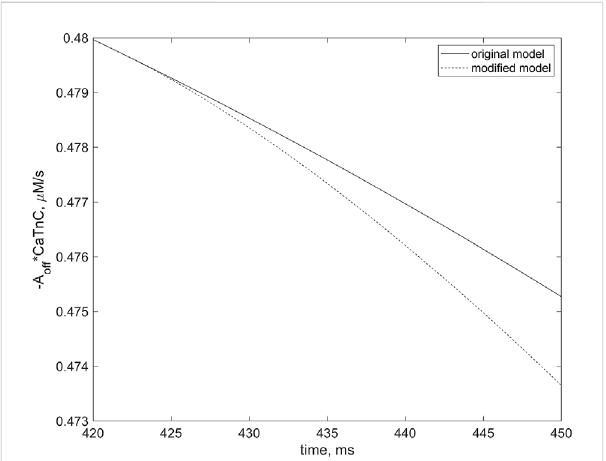
FIGURE 13 Differences in rates of the dissociation of CaTnC complexes in twosimulations,indicating theroleofcooperativemechanismsofthis dissociation in EAD initiation. The curves correspond to the simulations depicted by dashed and solid lines, respectively, in Figure 12. The curve for the simulation in which the “ constant ” of [CaTnC] decay is willfully stopped in the numerical experiment to depend on the number of Xbs bound (dashed line) in contrast to the original simulation in which the EAD occurs (solid line). The dashed line slopes more steeply than the solid line. The left frame of the panel corresponds to the moment of the cooperativity dependence switch (420 ms), indicated by the arrow in Figure 12A. The curves are shown for the fi rst 30 ms